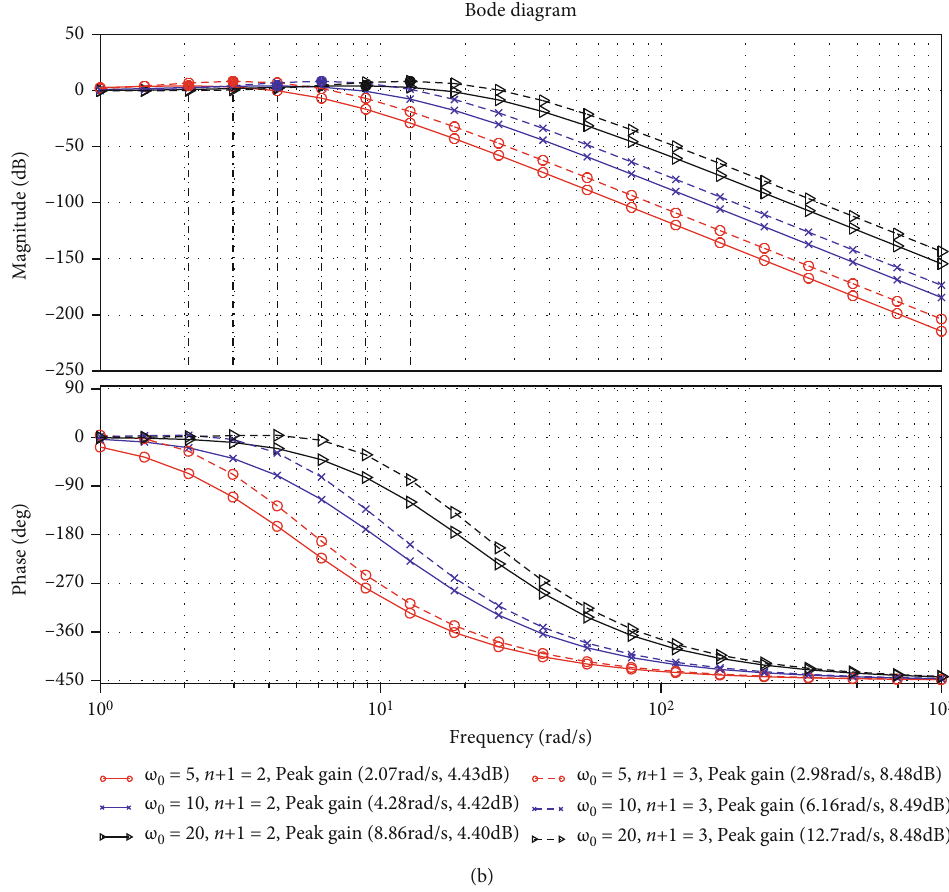
Figure 3: Intermediate-frequency and high-frequency characteristics of high-order LESO disturbance estimates: (a) system order is 3; (b) system order is